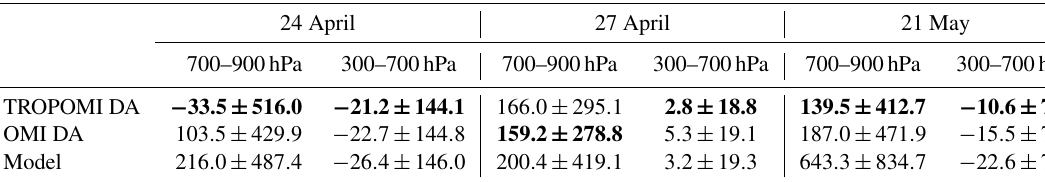
Table 4. Mean bias (MB) against the ATom-4 aircraft-campaign observations in the lower (700–900hPa) and middle–upper troposphere (300–700hPa) over coastal areas of the western United States (32–37 ◦ N, 117.25–122.5 ◦ W) on 24 and 27 April and 21 May 2018. MB is expressed in parts per trillion by volume (pptv). Boldface denotes the best agreement with in situ observations. The ranges of MB are the standard deviations of individual values in each pressure bin. “Model” indicates the control model simulation.